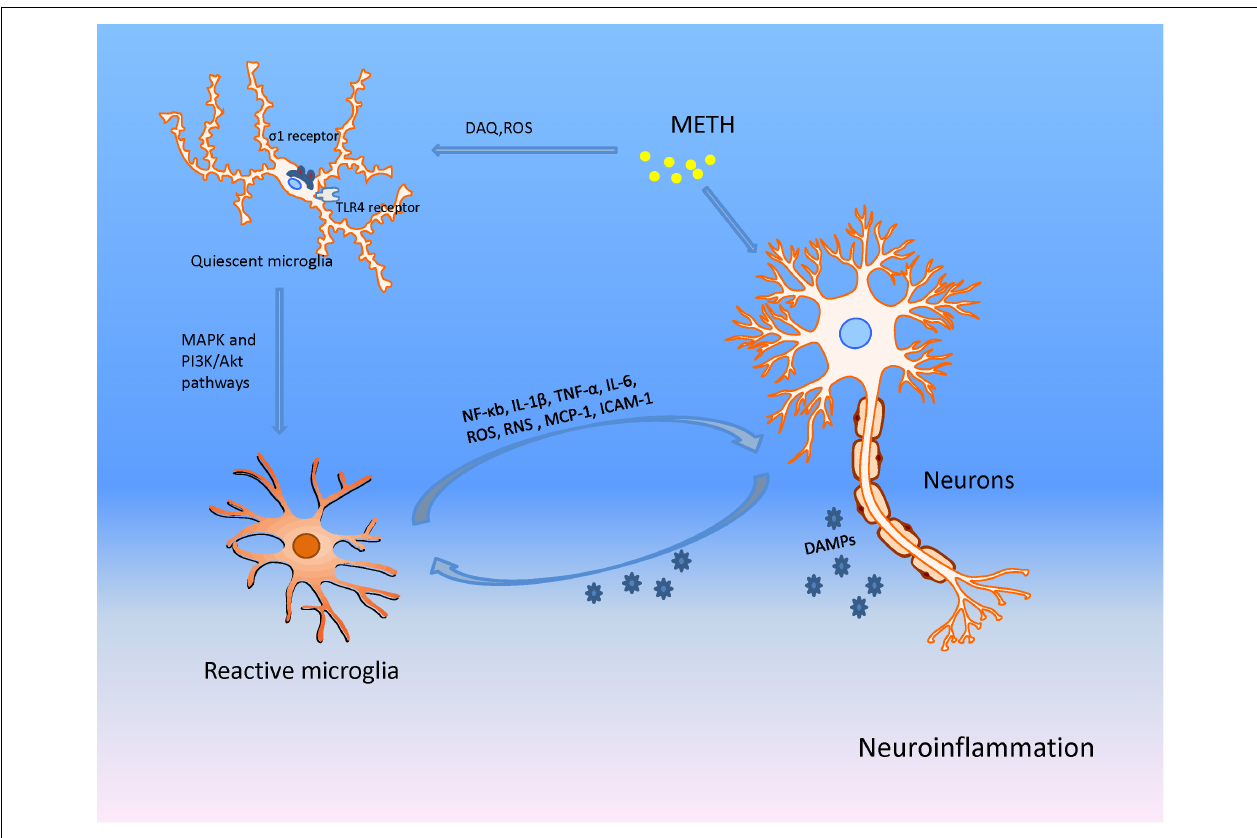
FIGURE 4 | METH produces neuronal damage through microglia associated neuroinflammation in addition to direct actions on neurons. METH damages presynaptic terminals of neurons causing the production of DA-quinone (DAQ) and sequential ROS; these facilitate microglial activation. The activated microglia then increase production of nuclear factor-kappa B (NF- κ B), tumor necrosis factor- α (TNF- α ), interleukin 6 (IL-6), interleukin 1 β (IL-1 β ), monocyte chemo-attractant protein 1 (MCP-1), ICAM-1, ROS, and RNS, promoting neuroinflammation and neuronal injury. The damaged neurons release DAMPs that act on microglia, and aggravate the inflammation and eventual neurotoxicity through the positive feedback